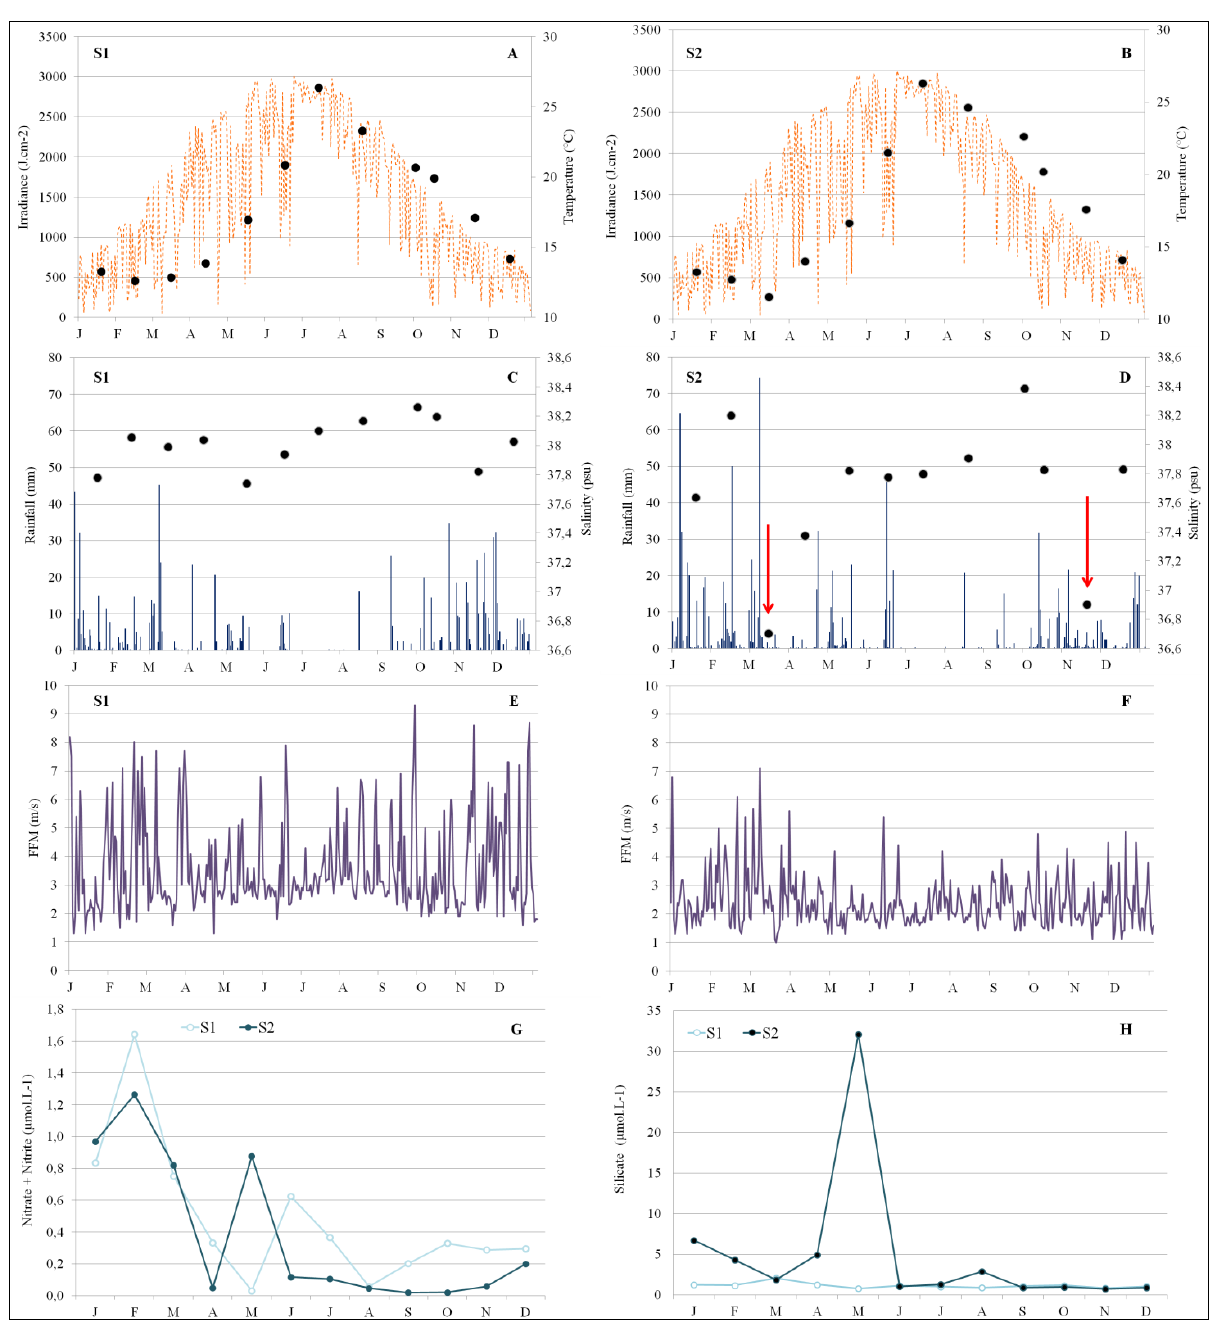
Figure 8. Spatio-temporal variations of subsurface environmental parameters during 2010 in the two stations (S1 and S2); ( A ) and ( B ): subsurface temperature (°C; dots; right scale) and mean daily irradiance (J·cm −2 ; line; left scale); ( C ) and ( D ): weekly rainfall (mm; bars; left scale) and subsurface salinity (psu; lines; right scale); ( E ) and ( F ): daily mean wind velocity; ( G ): Dissolved inorganic nitrogen concentration, nitrite + nitrate; ( H ):